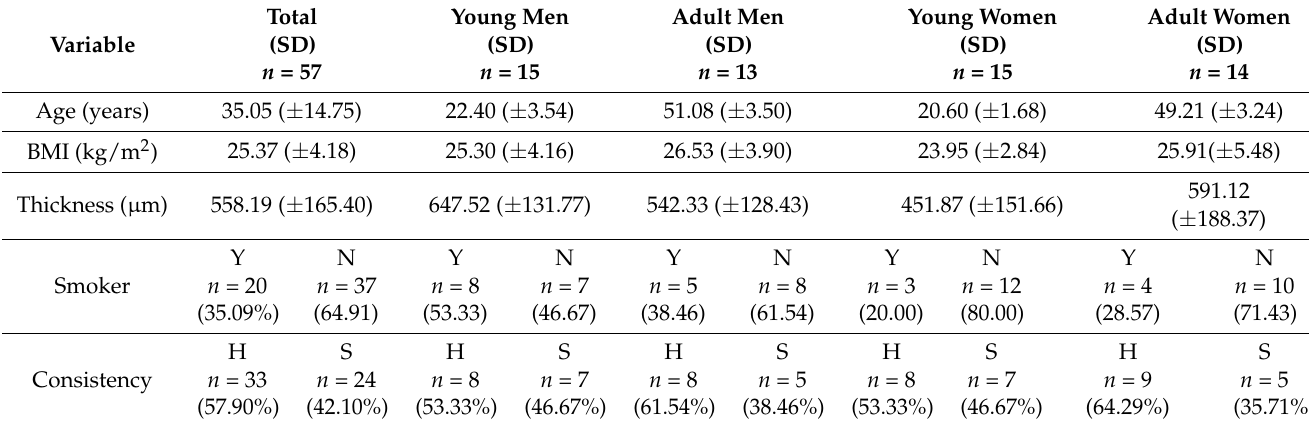
Table 1. Description of the sample chosen to develop the predictive model of nail consistency. n , sample size; SD, standard deviation; BMI, body mass index; kg, kilograms; m 2 , square metre; µ m, micrometer; Y, yes; N, no; H, hard; S,